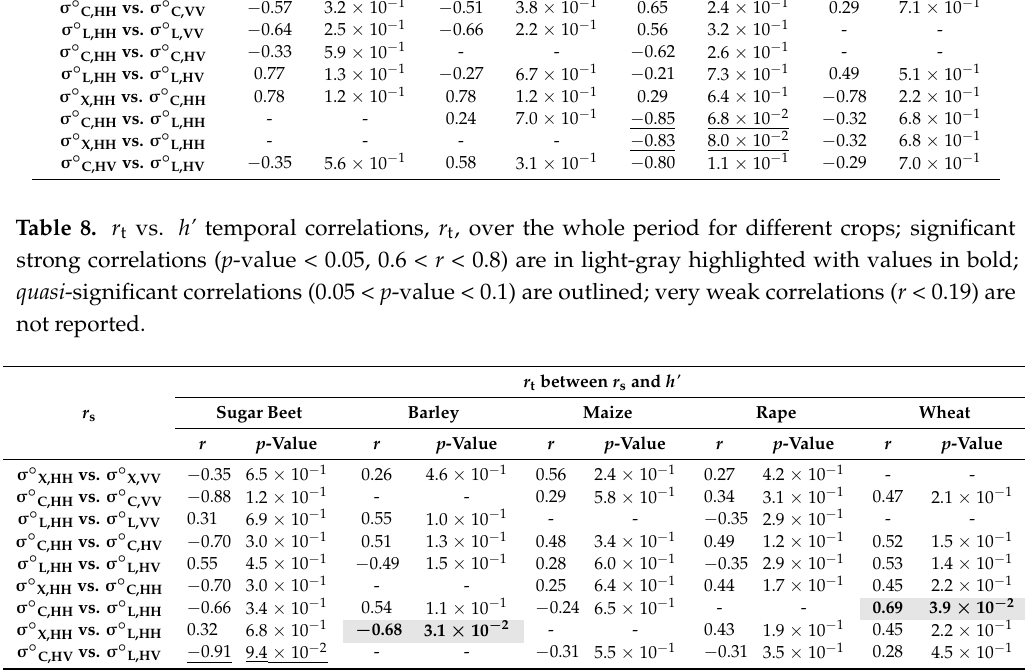
σ ◦ X,HH vs. σ ◦ X,VV